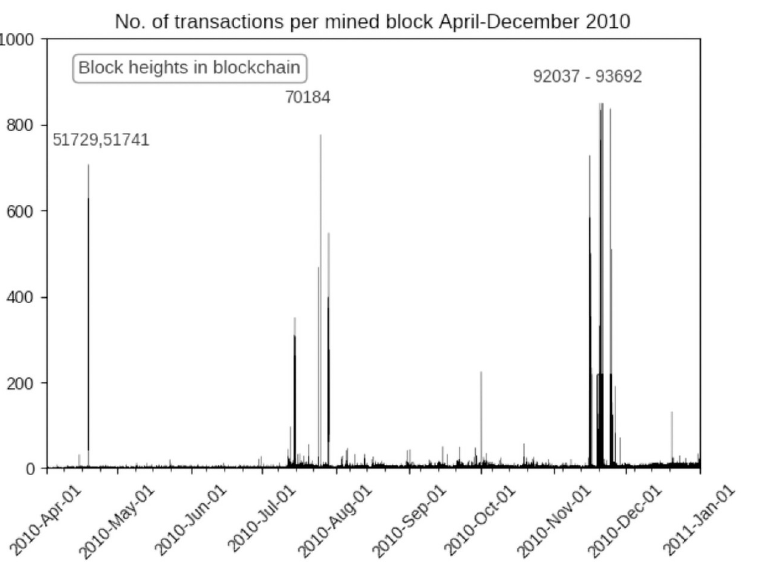
Fig 8. Average number of transactions/block mined in period of interest in